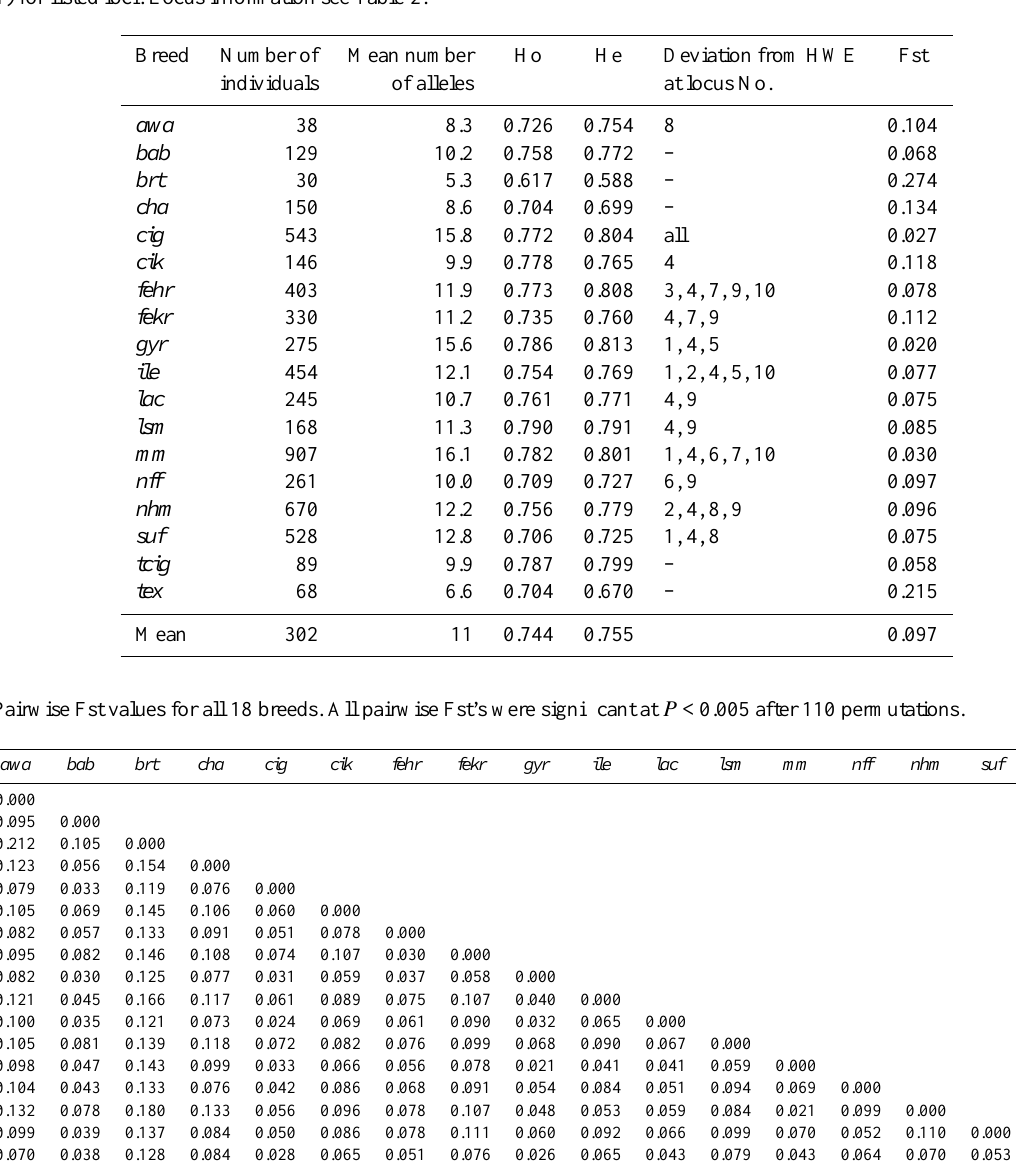
Table 3. Genetic diversity and information to HWE for all 18 breeds. Number of individuals and mean number of alleles per breed are given. Ho (observed heterozygosity), He (expected heterozygosity), and single Fst for each breed. Deviations from HWE were significant ( P <0.001) for listed loci. Locus information see Table 2.